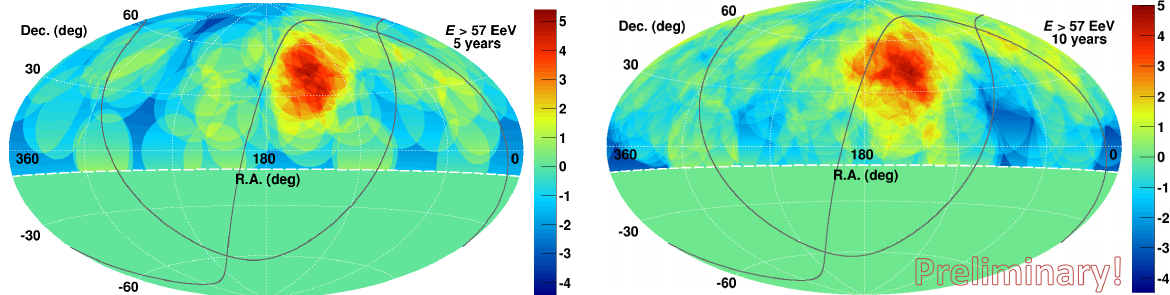
Figure 2. (Left) A significance map in the equatorial coordinates of arrival directions of UHECR events with E > 57 EeV for events observed in the 1st 5 years of Telescope Array data. Events are smoothed by 20 ◦ oversampling radius circle. (Right) A significance map of UHECR events with E > 57 EeV for the first 10 years of data. Here, the events are smoothed by 25 ◦ oversampling radius circle which was determined to maximize the significance.